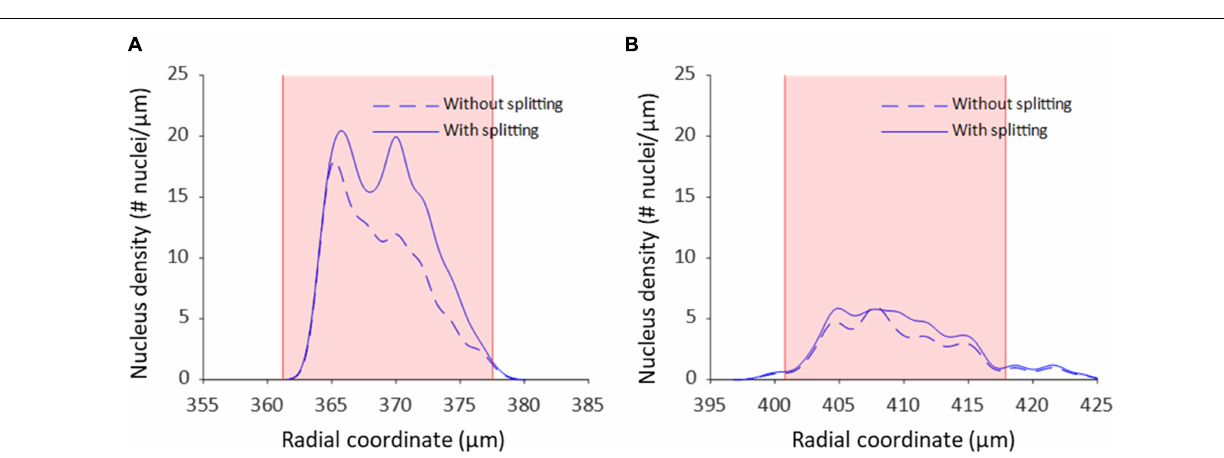
FIGURE 9 | Nucleus splitting makes VSMC layers more distinct in transmural cell density distributions. (A) Nucleus density as a function of radial location for a sample of a wild type animal (control Apoe − / − ) with high cell content. By splitting structures with nuclei from different layers the layered organization of VSMCs becomes more prominent. Multi-nucleus structures are predominantly on the adventitial side of the vessel wall. (B) Nucleus density as a function radial location for a sample from the VSMC apoptosis group ( SM22 α -hDTR Apoe − / − ) with low cell content. Multi-nucleus structures are less frequent and spread more evenly throughout the vessel wall of the low cell content vessel compared to the high cell content vessel. Shaded (pink) areas denote the media in each